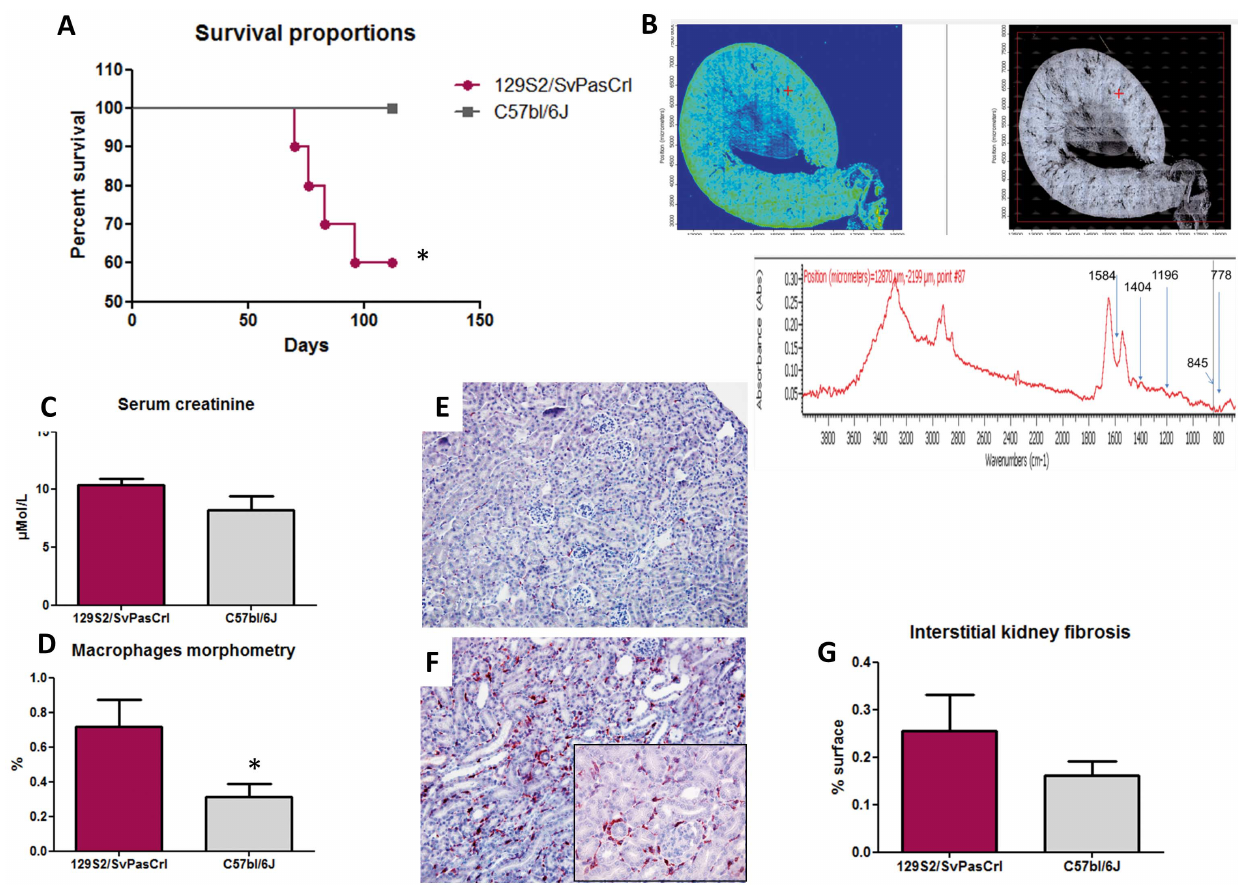
Figure 3. Survival study and kidney injury in 129S2/SvPasCrl and C57BL/6J mice. A , Survival proportions of mice from both strains before sacrifice at 16 weeks. 129S2/SvPasCrl mortality was significantly increased (p=0.045) and necropsy revealed kidney dilation due to urolithiasis. B , Infrared cartography of 129S2/SvPasCrl kidney slices revealed the presence of focal cystine aggregates in renal tissues (cystine tubular casts). C , Renal function as assessed by enzymatic serum creatinine dosage was not significantly impaired in 129S1/SvPasCrl mice (n=6) compared to C57BL/6J mice (n=9) at 16 weeks (p=0.11). D–F , Macrophage infiltrate in kidney tissues was assessed by morphometric analyses of F4-80 immunostaining and was increased in 129S2/SvPasCrl mice in comparison with C57BL/6J (n=5/group, p=0.046). Figures 3E and 3F are representative of